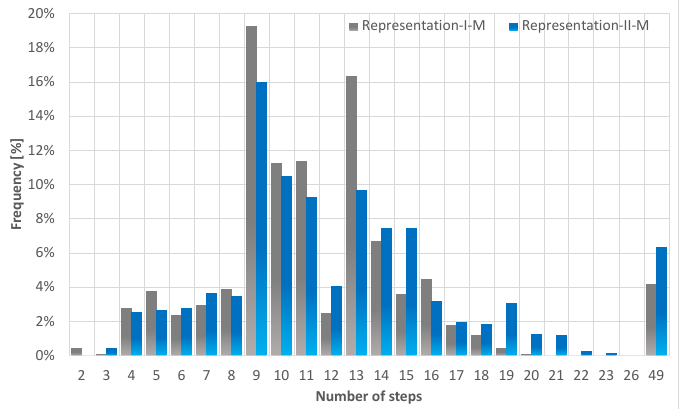
Figure 9. Comparison of the different solutions for the mirrored